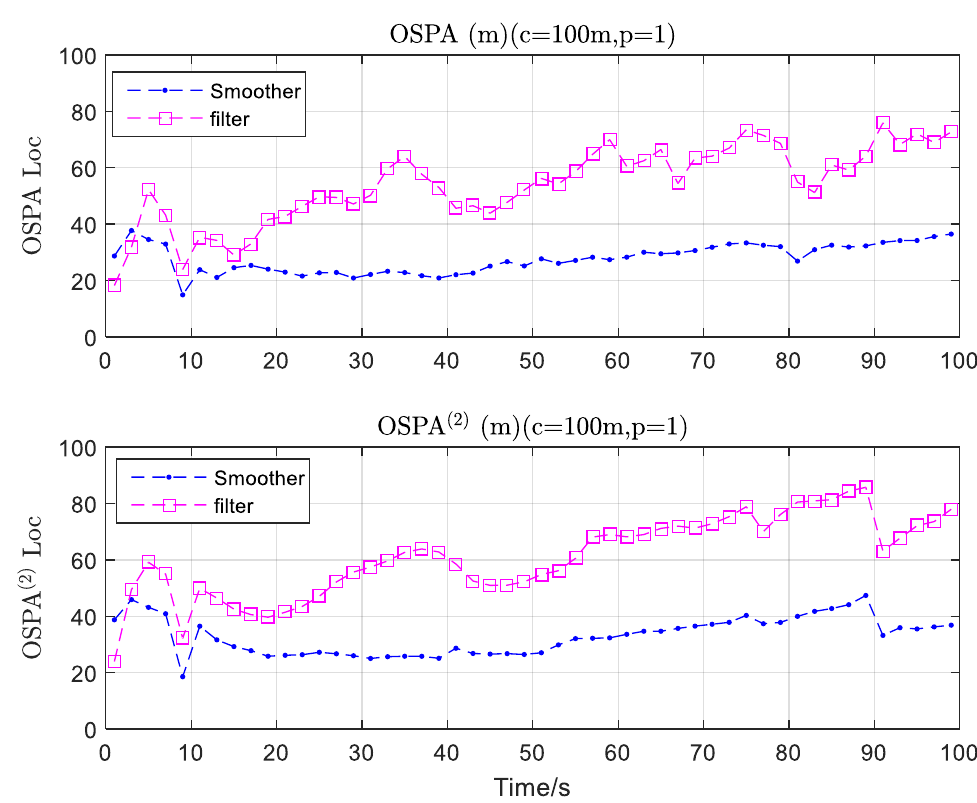
Figure 6. OSPA and OSPA (2) error versus time for the MF-GLMB-TBD smoother and corresponding GLMB-TBD filter.